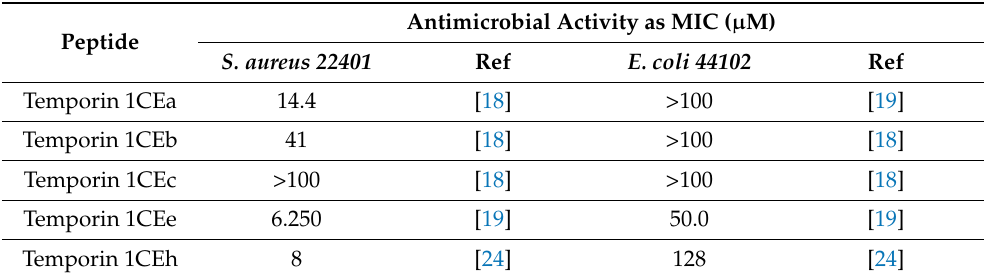
Table 2. Antimicrobial activity against selected microorganisms of peptides from Rana chensinensis .